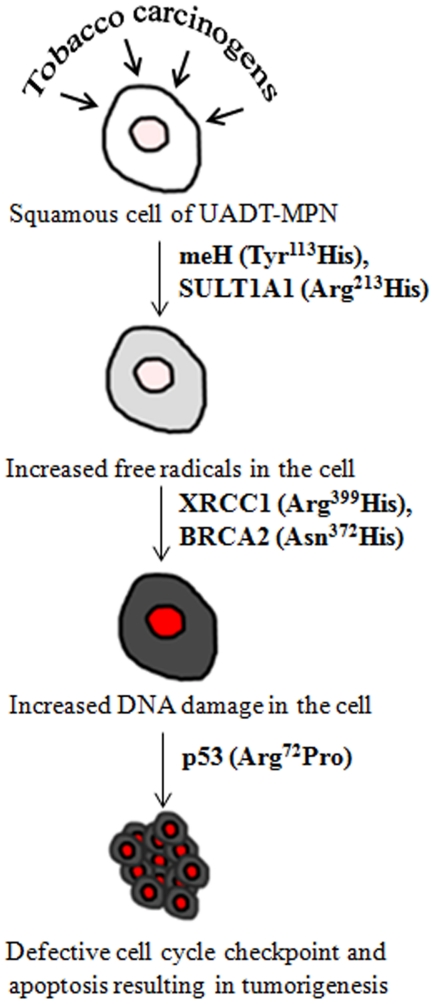
Cumulative effect model of polymorphisms predisposing to tobacco related cancers.